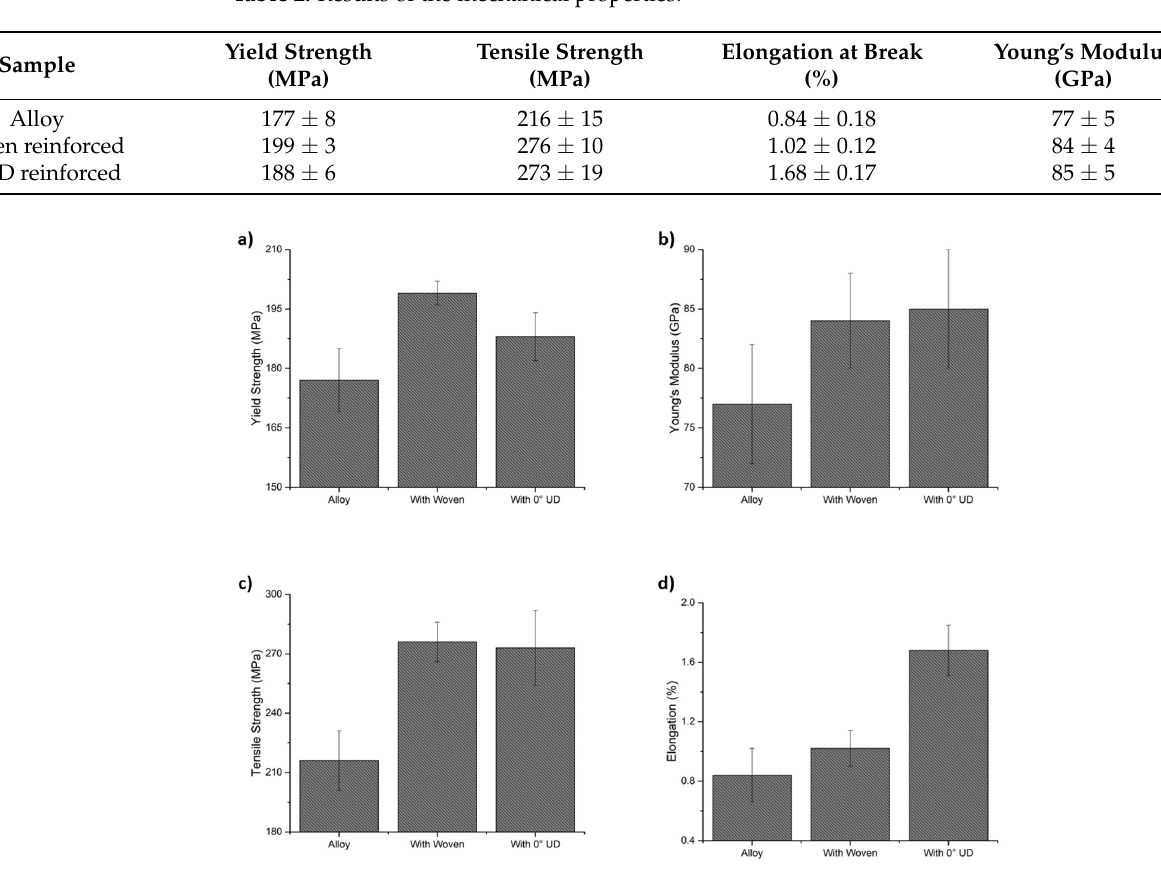
Table 2. Results of the mechanical properties.